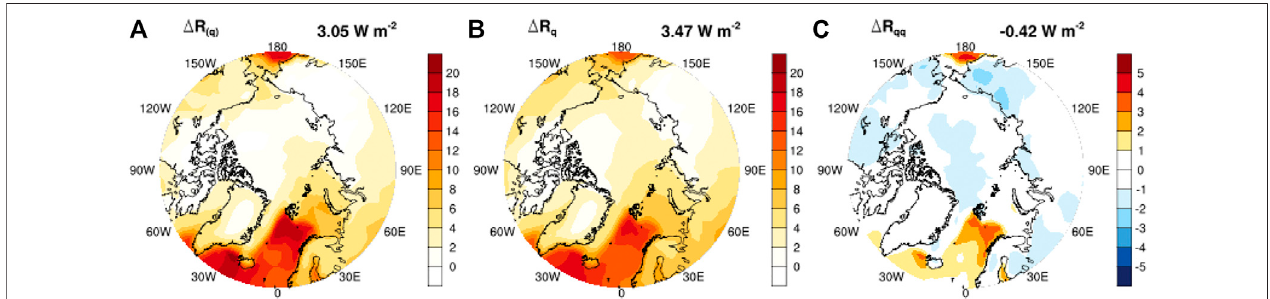
FIGURE 2 | Clear-sky univariate water vapor LW feedback. (A) RTM-computed (truth) overall univariate feedback, Δ R ( q ) ; (B) kernel-estimated univriate linear feedback, Δ R q , based on logarithmic scaling; (C) the residual (A – B) , i.e., the univariate nonlinear feedback, Δ R qq . Shown here is the clear-sky TOA LW radiation fl ux changedue tothewatervaporchangeinJanuaryinthe4xCO